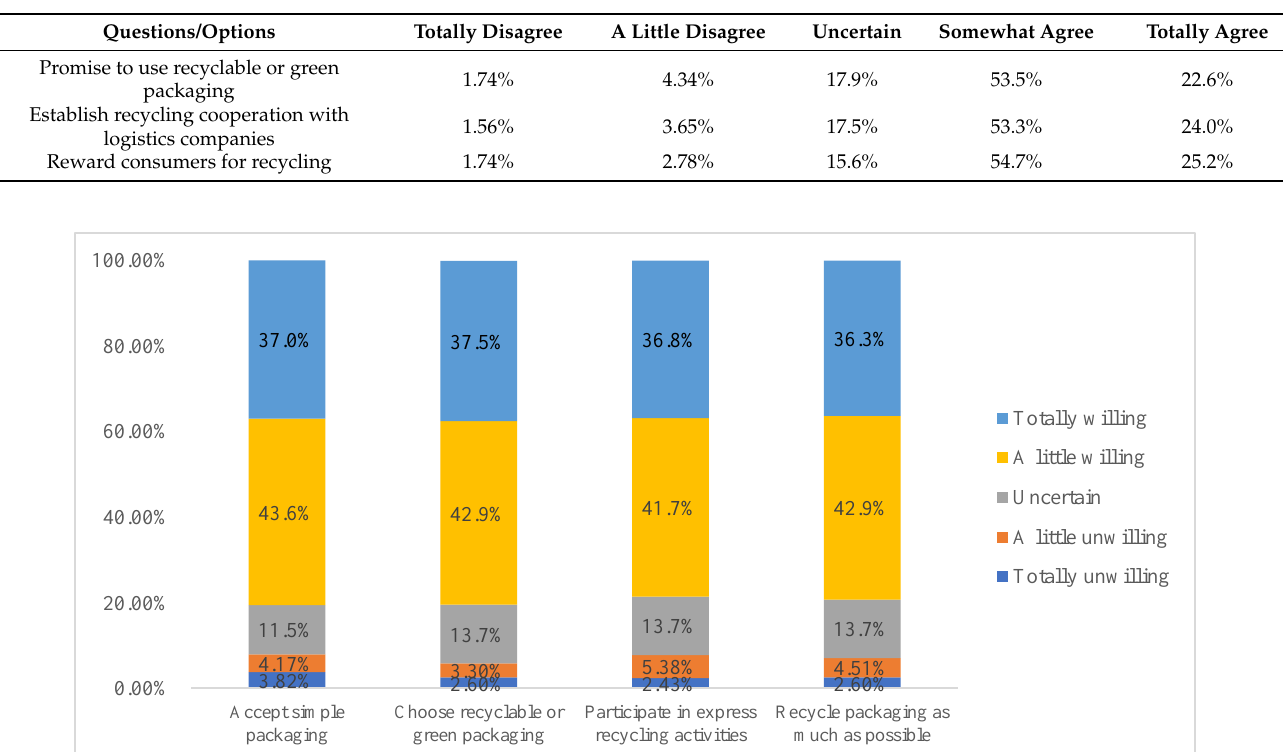
Table 7. Respondents’ awareness of e-commerce corporate responsibility.